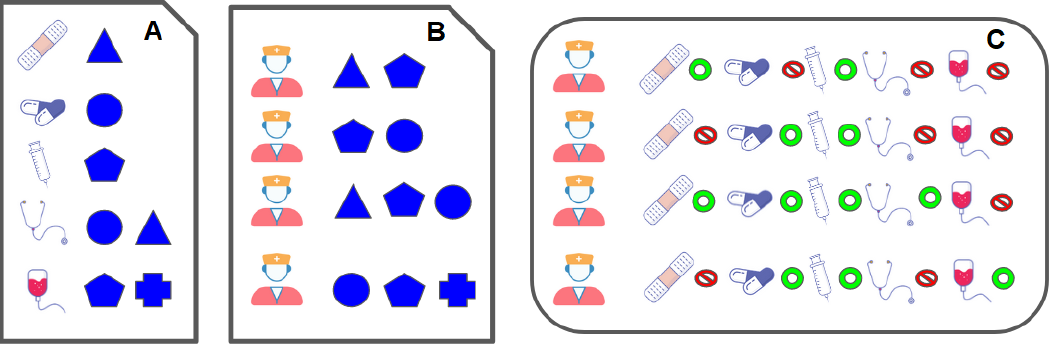
Figure 2. A qualification matrix ( C ) regarding job qualifications ( A ) and caregivers’ qualifications ( B